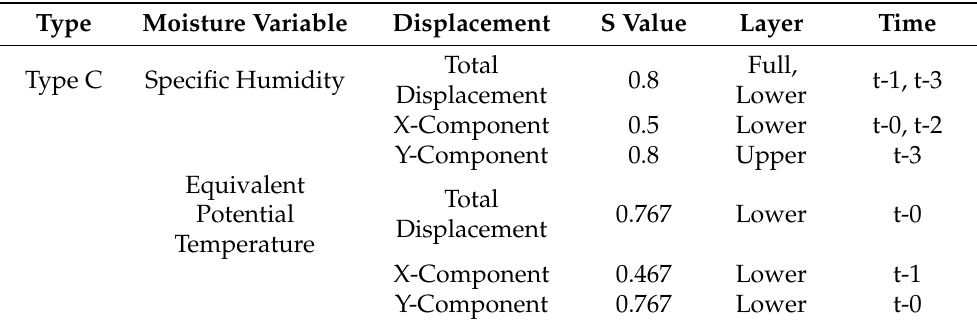
Table 5. Largest positive Spearman rank correlation coefficients simulated in Type C cases using both MYJ and YSU schemes. S values were taken from the WRF700mb_inflow region and are shown for each displacement along with the time when